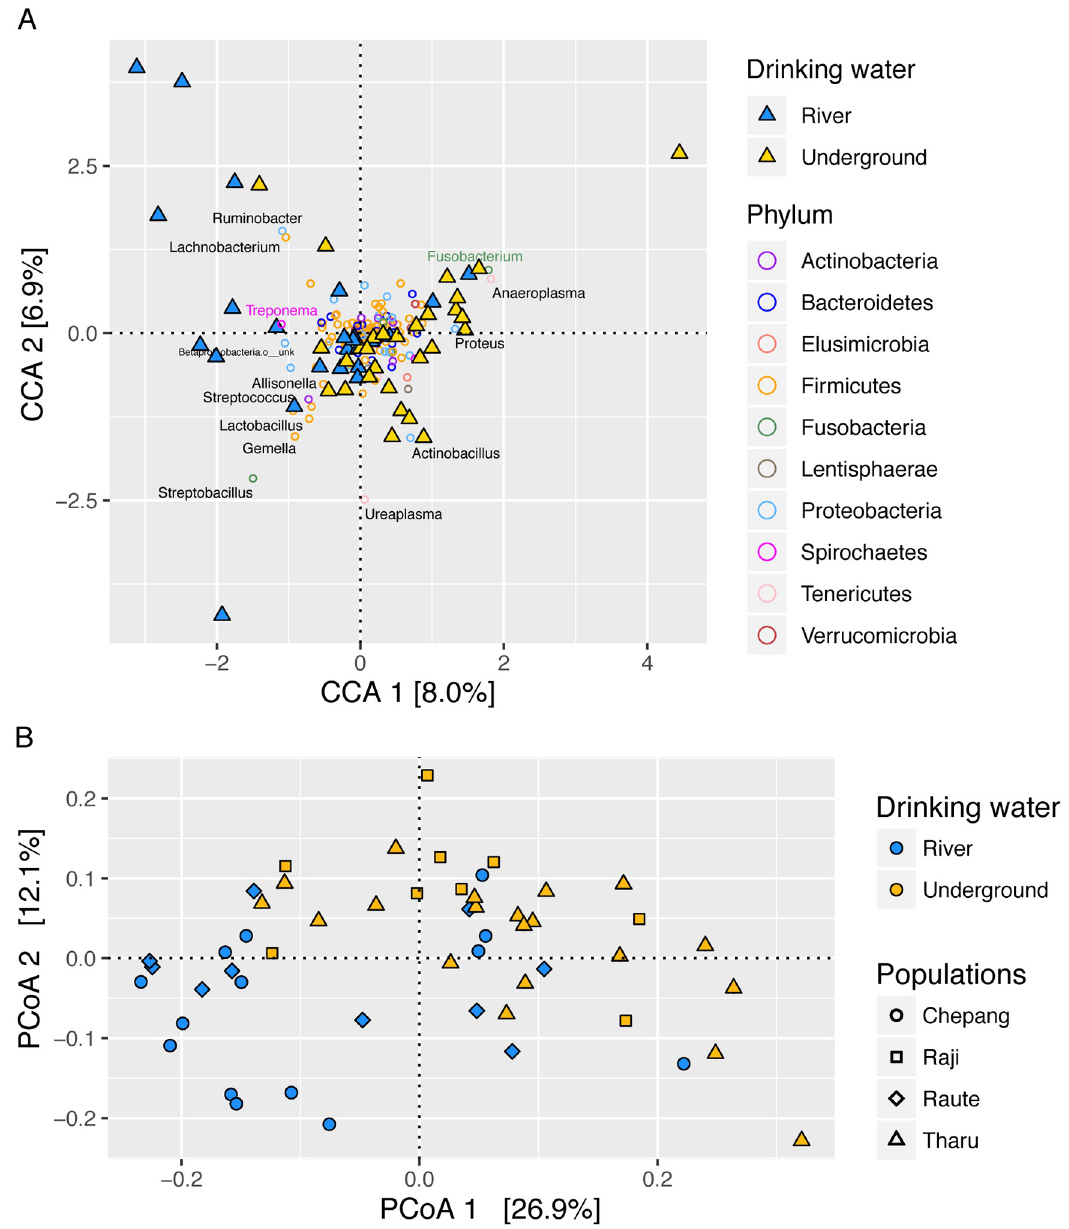
Fig 7. Gut microbiome composition is associated with environmental factors in Himalaya. (A) The two primary CCA axes and the proportion of constrained variance they explain are shown. Triangles represent individuals and circles represent genera. Individuals and genera are color coded by their respective drinking water sources and phyla. Drinking water and cooking fuel contributed most to CCA1, and sisnu (nettles) contributed most to CCA2. Genera labeled in grey contribute to the top two CCA axes. Among these, Fusobacterium and Treponema were significantly associated with drinking water. (B) PCoA of the unweighted UniFrac distances. Each dot represents an individual, colors indicate the two drinking water sources, and shapes represent different populations. Gut microbiomes of the Chepang (circles) and Raute (diamonds) who drink water from rivers and streams vary significantly from those of the Raji (squares) and Tharu (triangles). Statistical significance was assessed using PERMANOVA using the 10 variables that differentiate their lifestyles ( P value = 0.0001). The data underlying this figure can be found in S1 Data and S4 Table. CCA, canonical correspondence analysis; PCoA, Principal Coordinates Analysis; PERMANOVA, permutational multivariate analysis of